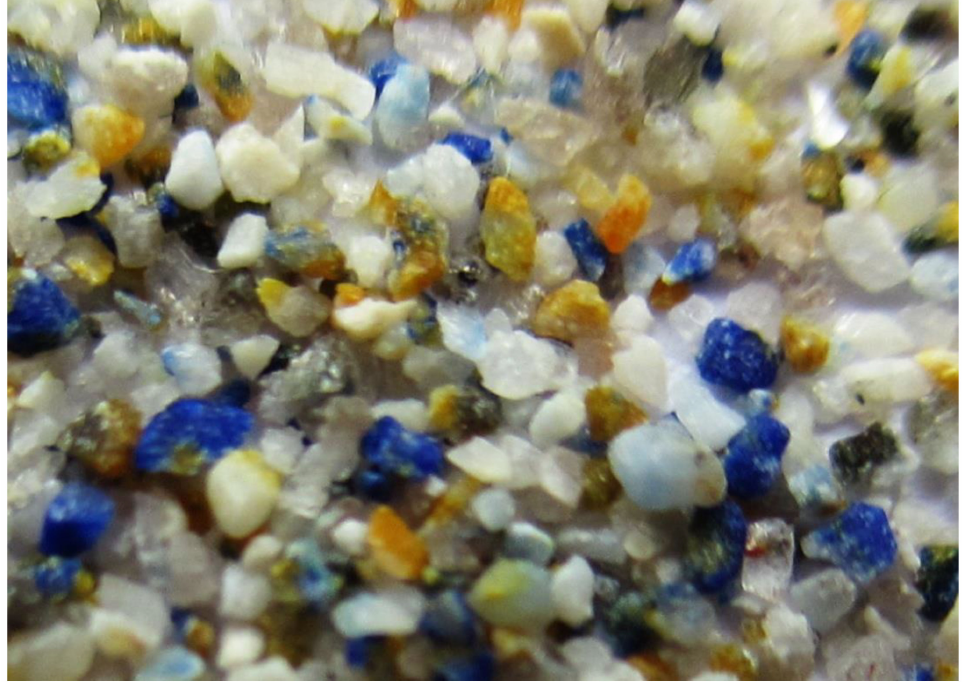
Figure 3. Crushed rock composed of orange–yellow sulfhydrylbystrite (Sample 11) intergrown with red–orange sulfhydrylbystrite variety (Sample 12), lazurite (deep blue), afghanite (pale blue), calcite (white), nepheline (brownish) and Sr-bearing feldspar (grey). FOV width: 12 mm. Sample 12 is sulfhydrylbystrite from the Malo-Bystrinskoe deposit with the compo- sition (wt.%): Na 2 O 14.72, K 2 O 6.89, CaO 4.85, Al 2 O 3 27.44, SiO 2 31.49, S 15.60, Cl